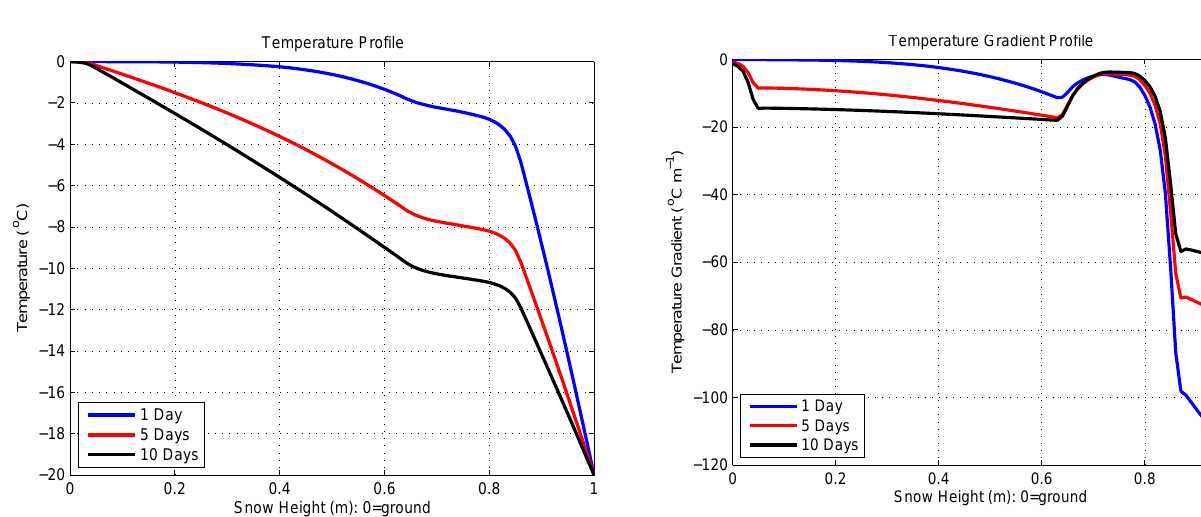
Figure 10. Snowpack temperature profile at 1, 5, and 10 days, re- spectively.